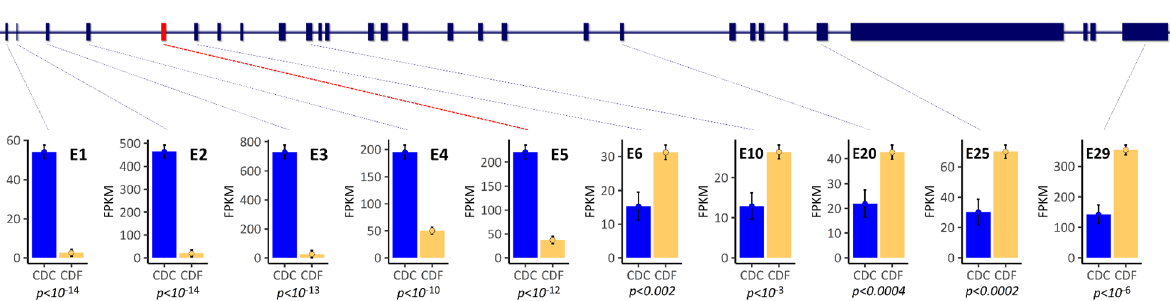
Figure 4. Exon-wise differential hepatic expression analysis of the APOB gene between CDC and CDF lactating cows. CDC denotes heterozygous carriers of the CD mutation; CDF animals are homozygous wild type. E-numbers indicate the analysed exons. Blue bars represent the expression levels of CDC animals; yellow bars represent those of CDF individuals. Indicated are lsmeans ± standard error. p values in italic represent the statistical significance of the differential expression between CDC and CDF. The red box in the gene model indicates the exon 5 affected by the LTR